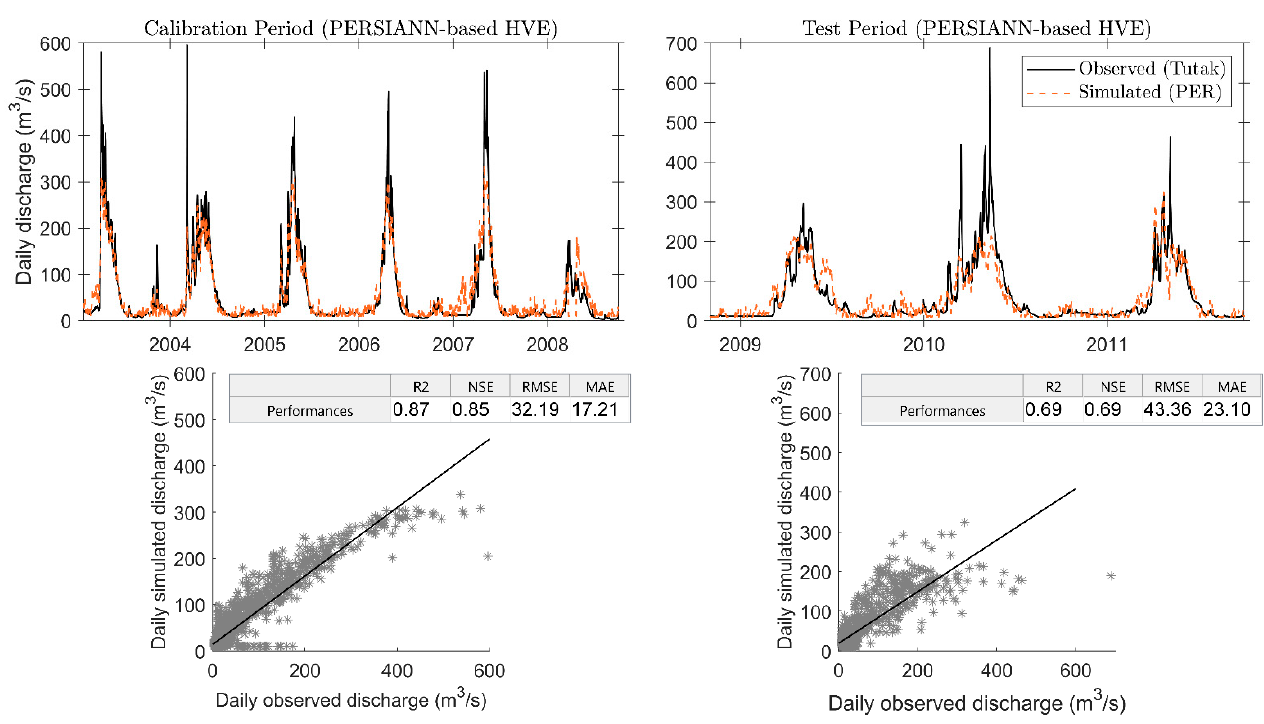
Figure 12. HVE results using PERSIANN-CCS SBP data.